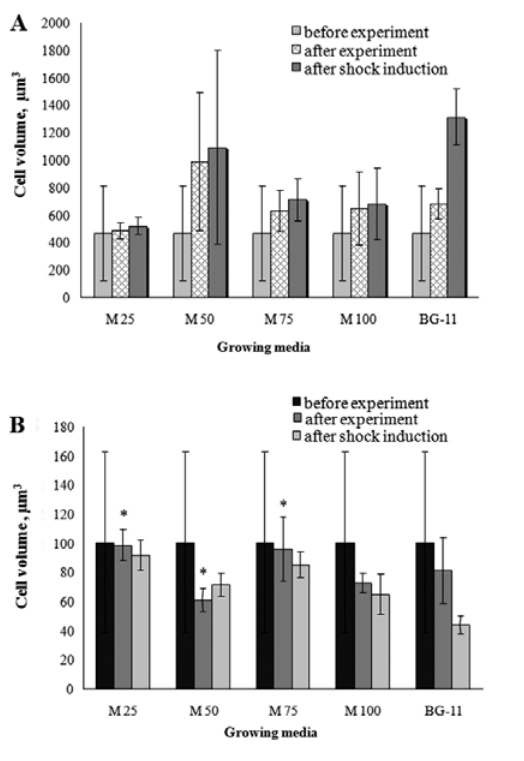
Fig. 5. Variations of Chlorella (A) and Scenedesmus (B) species cell size in wastewater at different concentrations